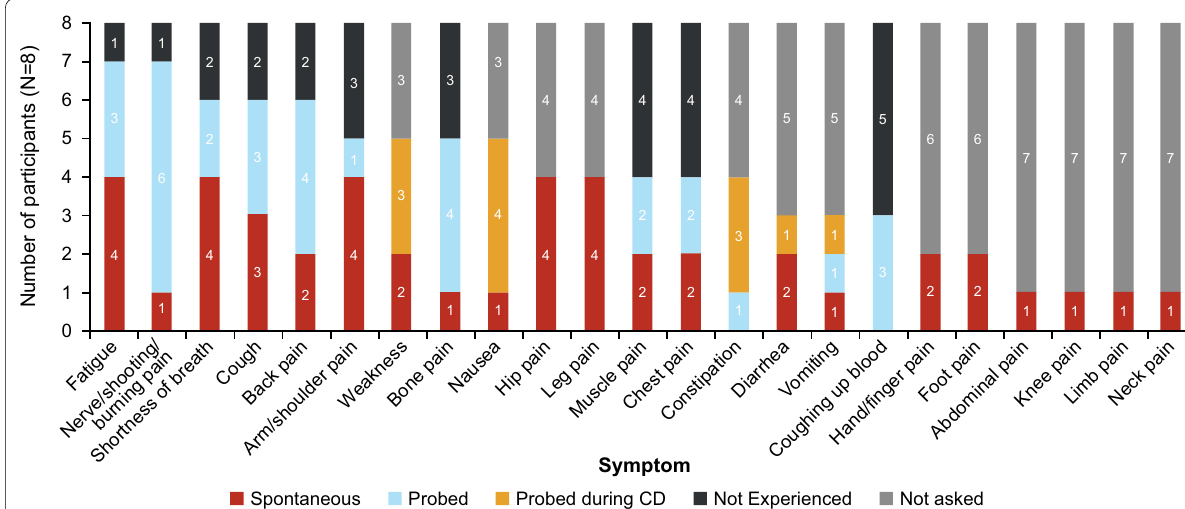
Fig. 3 Overview of Symptoms Reported. CD, cognitive debriefing